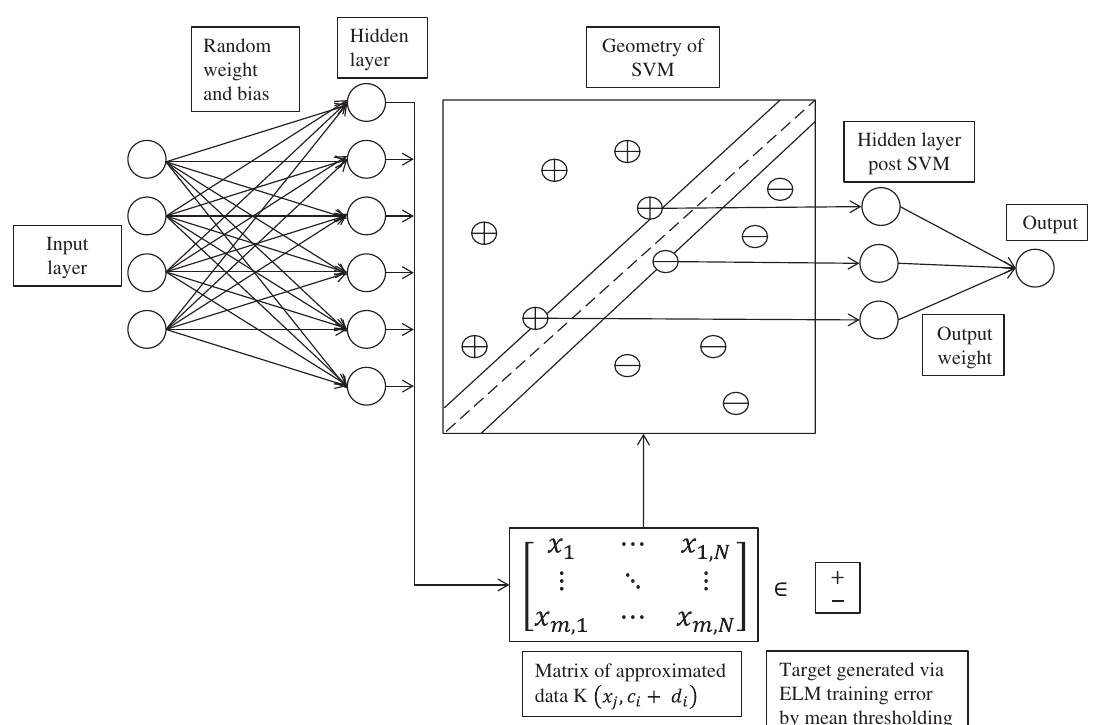
Figure 1: Structure of the Proposed